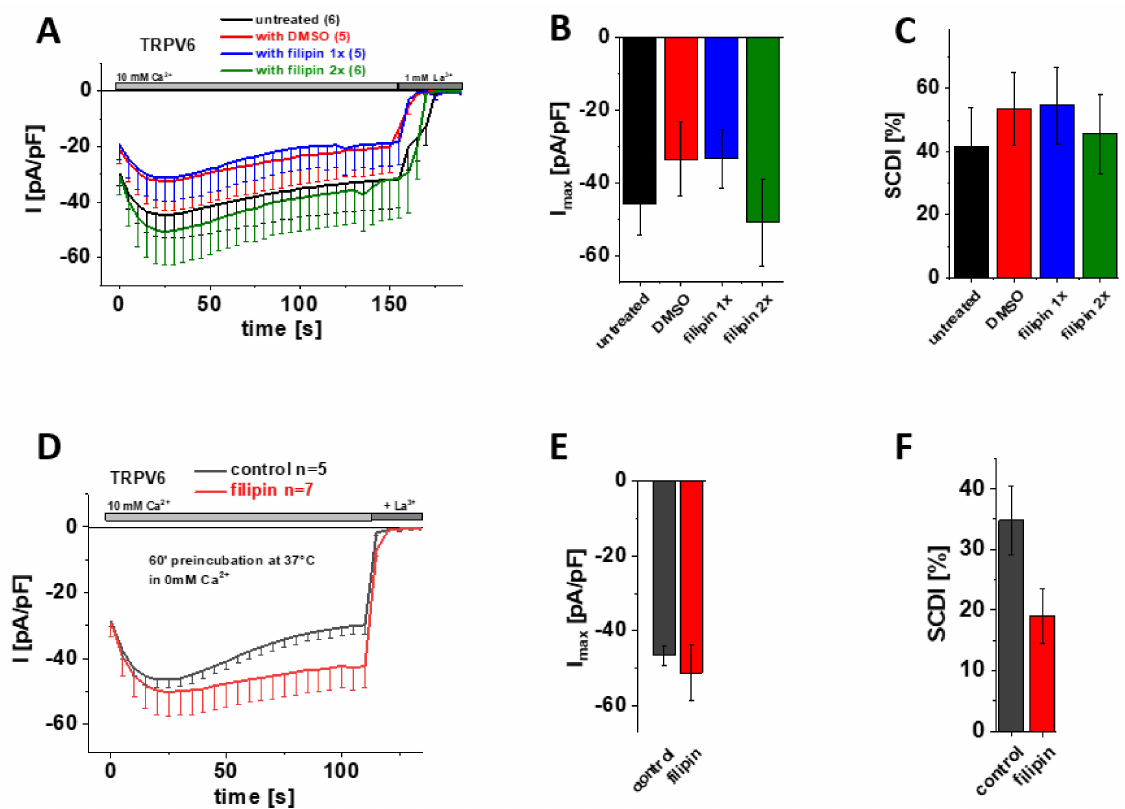
Figure 5. Treatment with filipin has no effect on maximum currents and SCDI of TRPV6 WT currents. ( A ) Averaged time course of whole-cell currents (mean ± SEM) recorded from HEK293 cells expressing TRPV6 WT. Cells were treated with DMSO (control, red), with 1 µ g/ µ L filipin upon transfection (blue, filipin 1x) or with 1 µ g/ µ L filipin upon transfection and media exchange (green, filipin 2x). Untreated cells (black) were taken as an additional control. Measurements were carried out in 10 mM Ca 2+ extracellular solution and currents were blocked by 1 mM La 3+ at the end of the experiments, as indicated by the grey bars. ( B ) Block diagram of maximum currents according to measurements in ( A ). ( C ) Block diagram of the extent of SCDI in % according to measurements in ( A ). ( D ) Averaged time course of whole-cell currents (mean ± SEM) recorded from HEK293 cells expressing TRPV6 WT. Cells were preincubated in 0 mM Ca 2+ extracellular solution